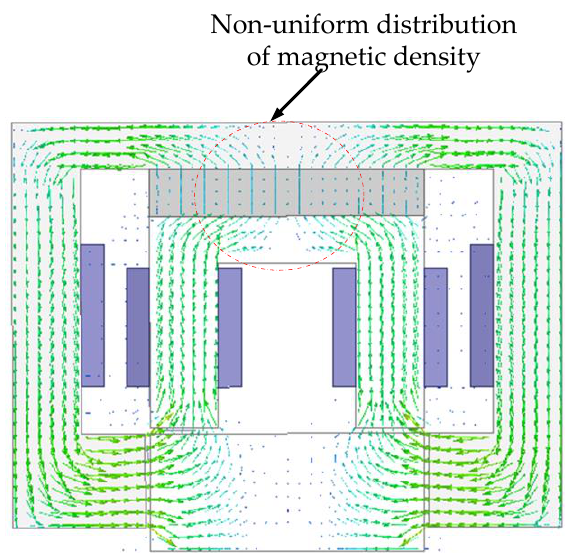
Figure 5. Distribution of flux density vectors of the PM.